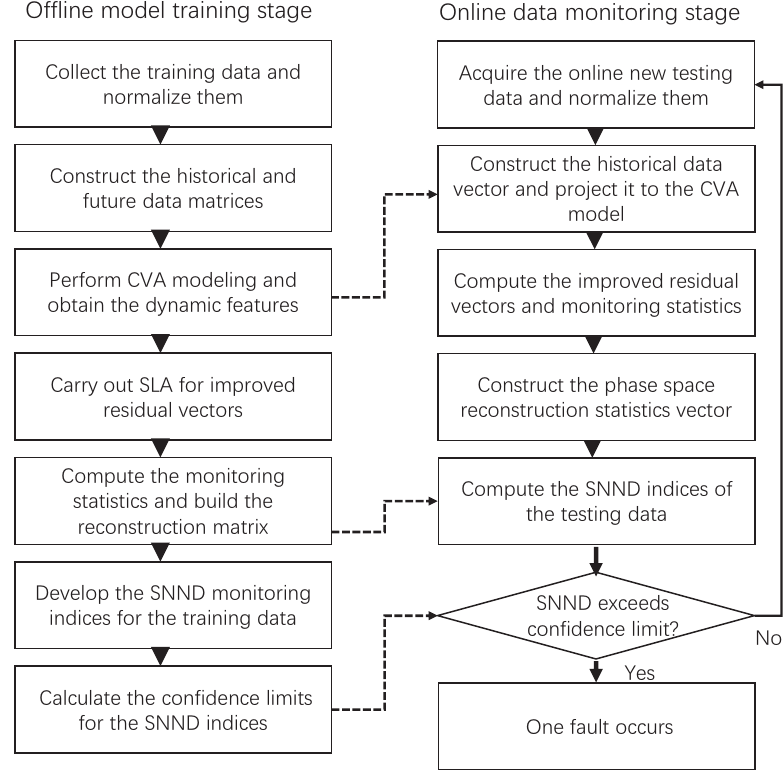
Figure 1. Flow chart of disturbance detection by SLCVA k